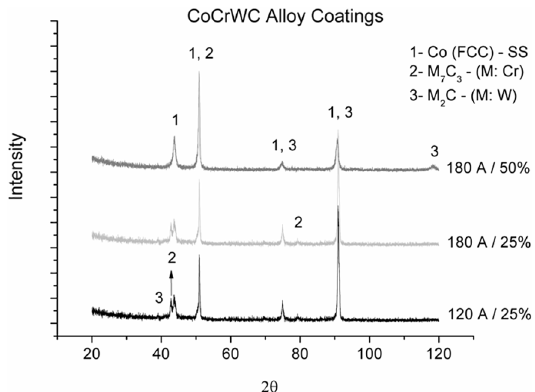
Figure 9. Typical difractograms for multiple bead coatings.